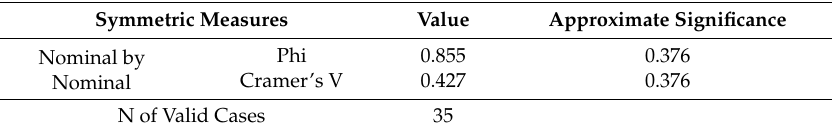
Table A10. Symmetric measures: Game * Education. Table 9. Chi-square tests: Game * Education.